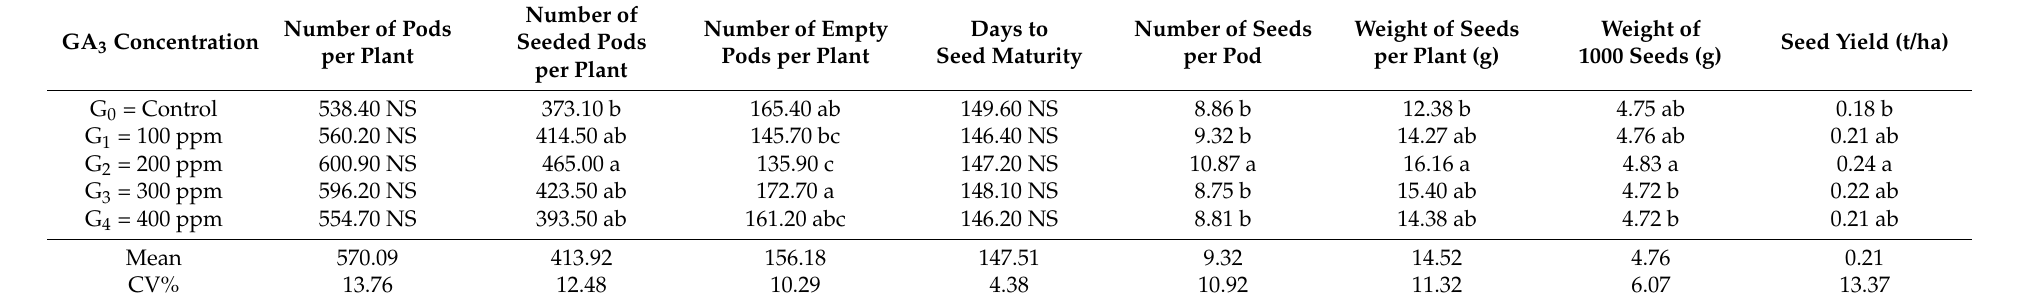
Table 4. The main effect of GA 3 concentration on seed yield and yield contributing traits in BU cauliflower-1.